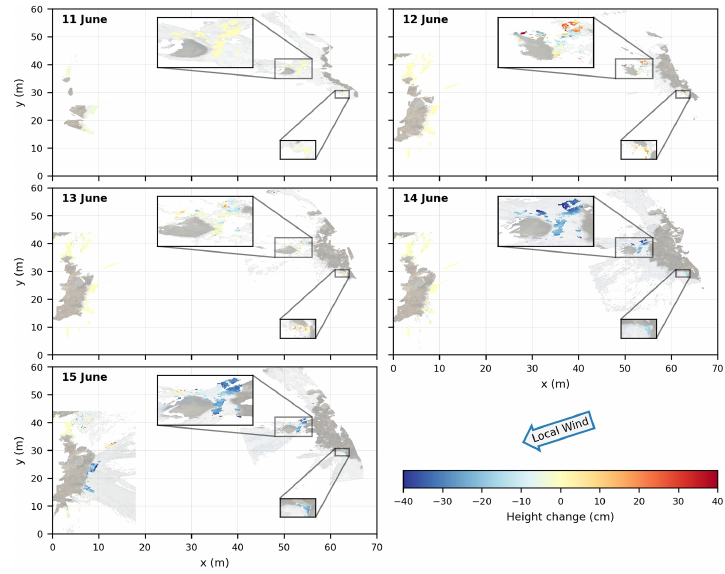
Figure A1. The resulting height change maps used for Fig. 4 plotted over the real-color orthoimages, which are used for distinguishing snow from bare ground, after removing isolated groups of cells and median filtering. The insets show zoomed areas of the upwind edge for more